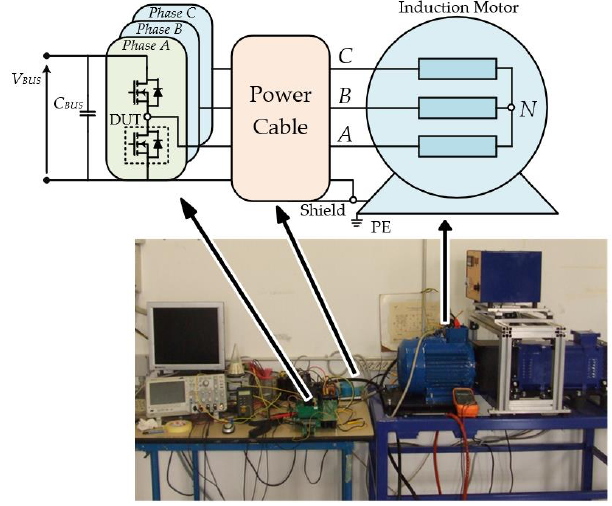
Figure 1. Experimental setup used for testing the effect of the long power cable connected to the motor on the power semiconductors. Table 1. Operating parameters of each power semiconductors used as DUT.